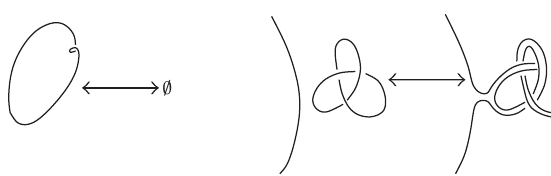
Figure 6: Blow up/down and handle slide over a trefoil